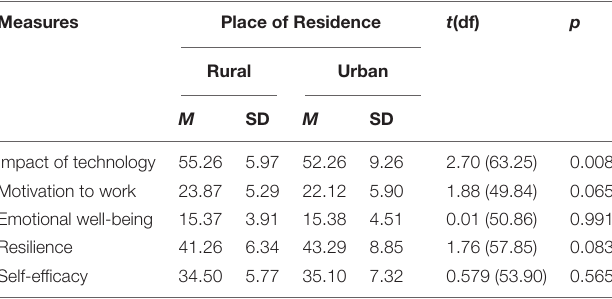
TABLE 4 | Mean comparison of scores of rural and urban groups on various